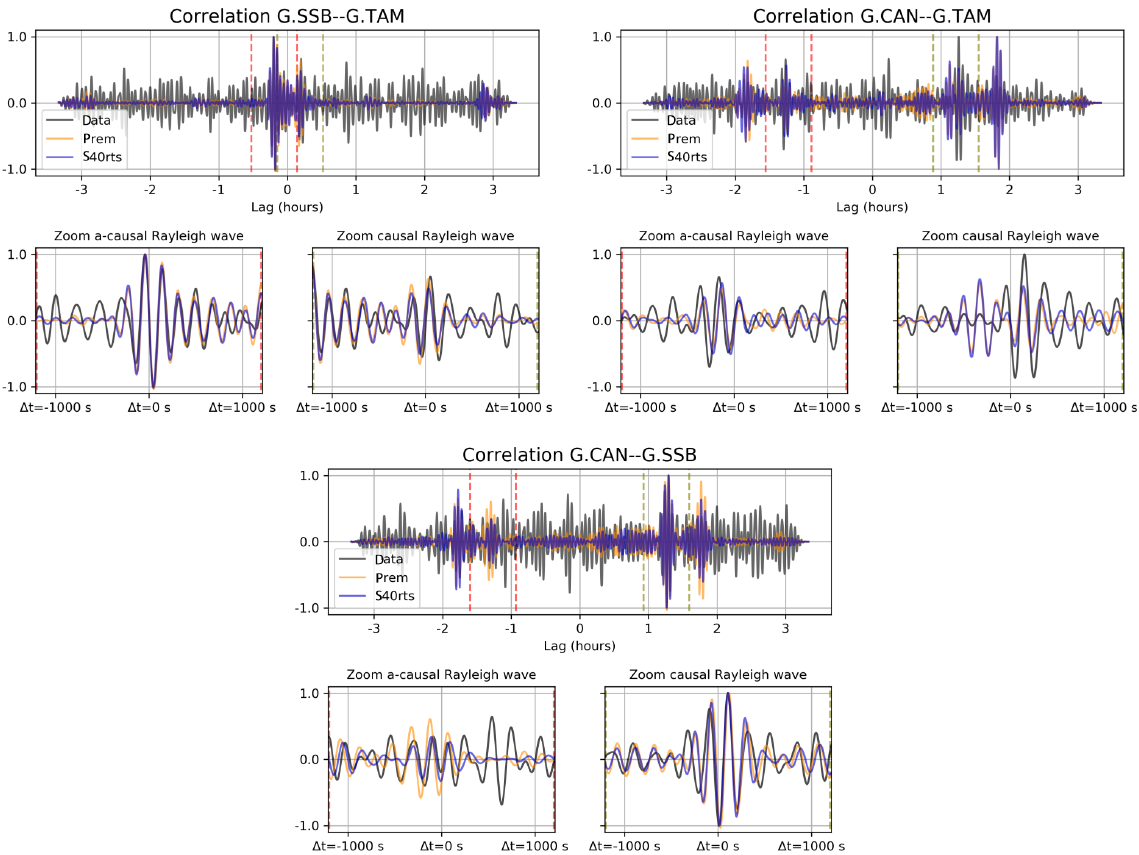
Figure 4. Forward modeled and observed cross-correlations. No fitting or inversion was undertaken; the forward model is built upon the hum mechanism by Ardhuin et al. (2015) and Deen et al. (2018) using PREM (yellow lines) and S40RTS (blue lines). Correlations are normalized by maximum amplitude. Red and green vertical lines indicate windows of ± 20min around a minor-arc surface wave traveling at 3.7kms − 1 . These are enlarged in the respective bottom panels.